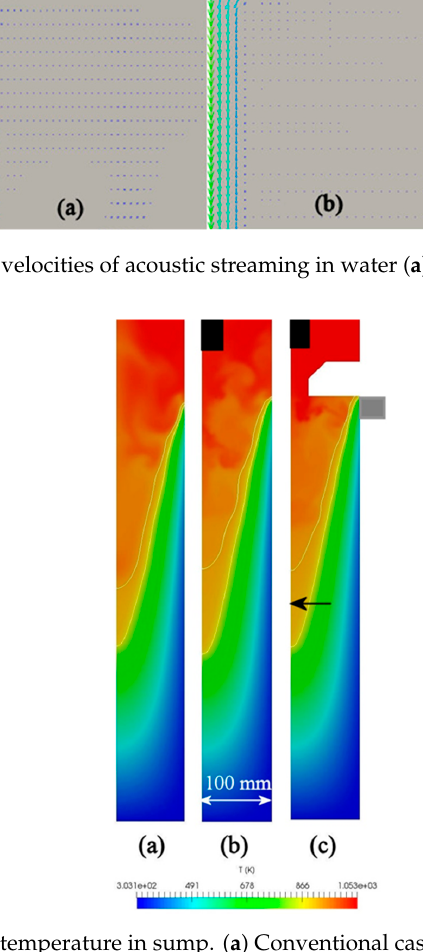
Figure 5. Distribution of temperature in sump. ( a ) Conventional casting, ( b ) UST HT casting, ( c ) UST FRHT casting. Table 1. Model parameters used for the DC casting simulation.